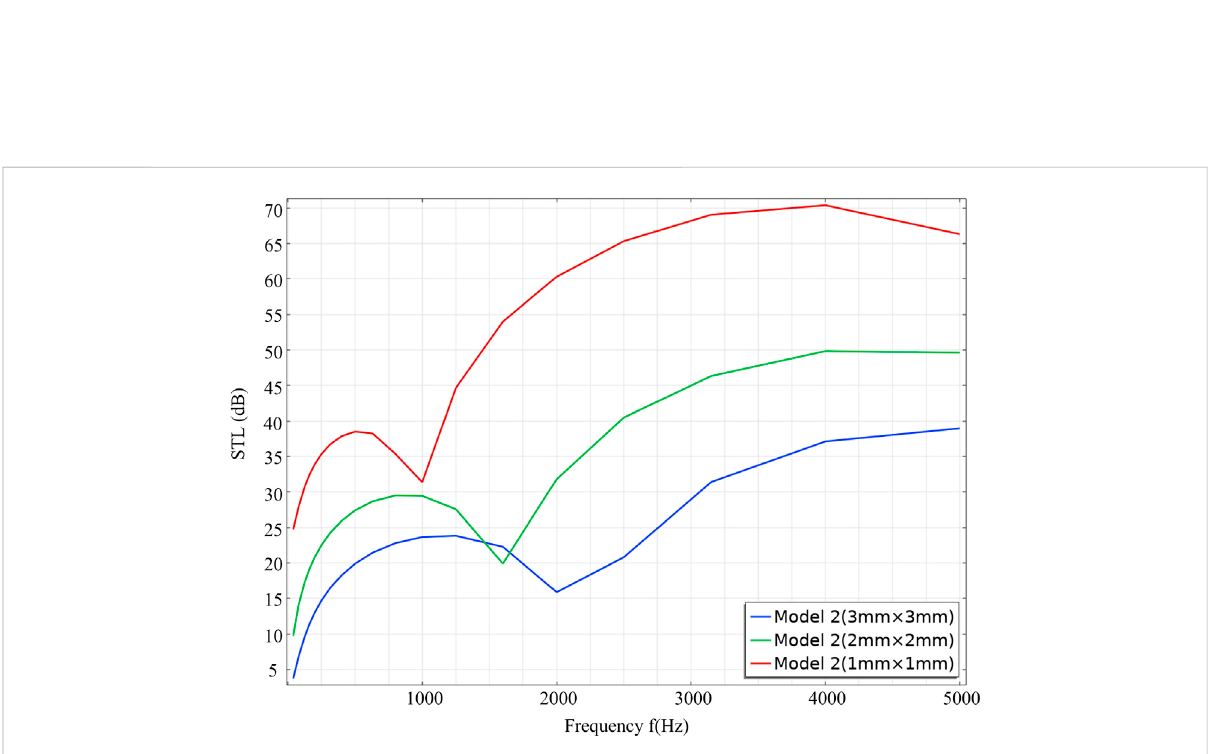
FIGURE 10 The STL of three